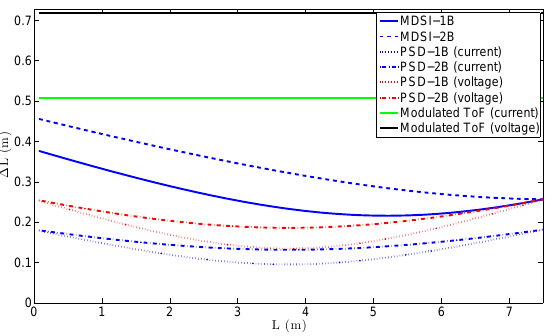
Figure 10. Distance error due to shot noise for the different ToF techniques with an adaptive number of accumulations and B . In the pulsed ToF techniques, T was set to 50 µ s IndoorMin (1000 T p